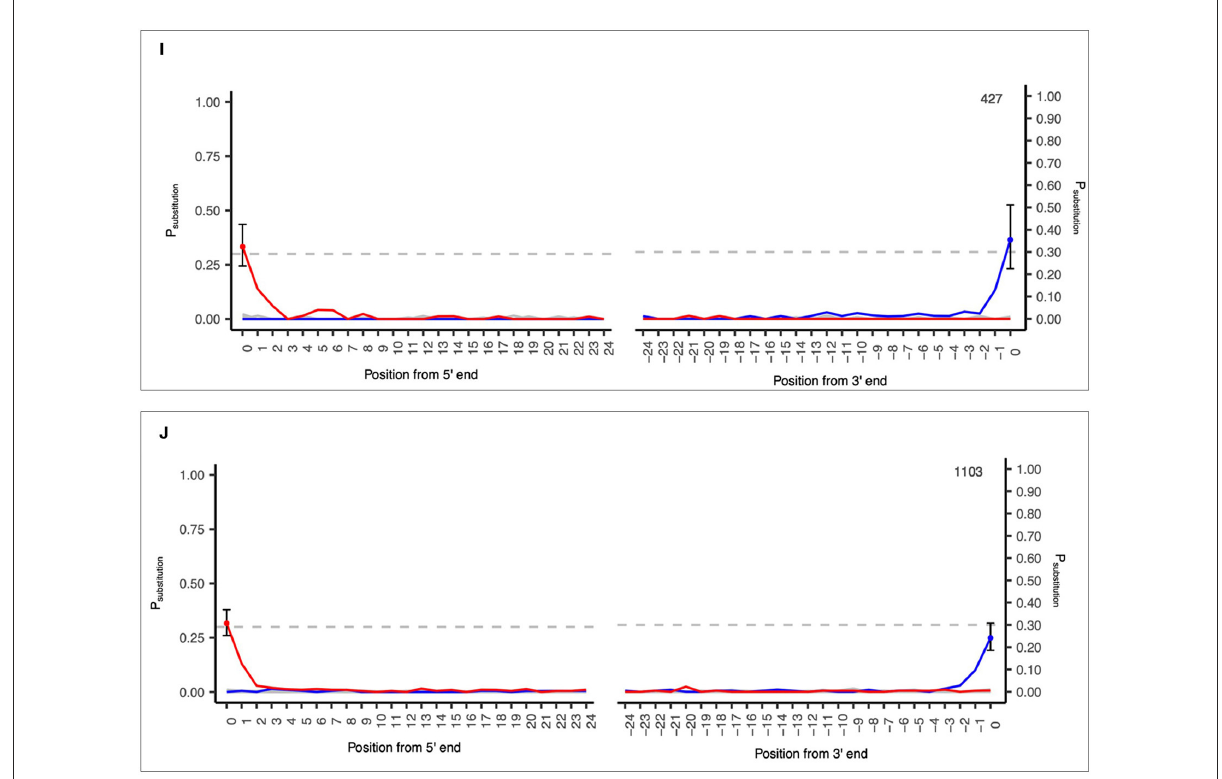
FIGURE5 (A–J) Observed credible intervals in each FASTA input of empirical data from unpublished Holocene dataset (Everett, 2021).